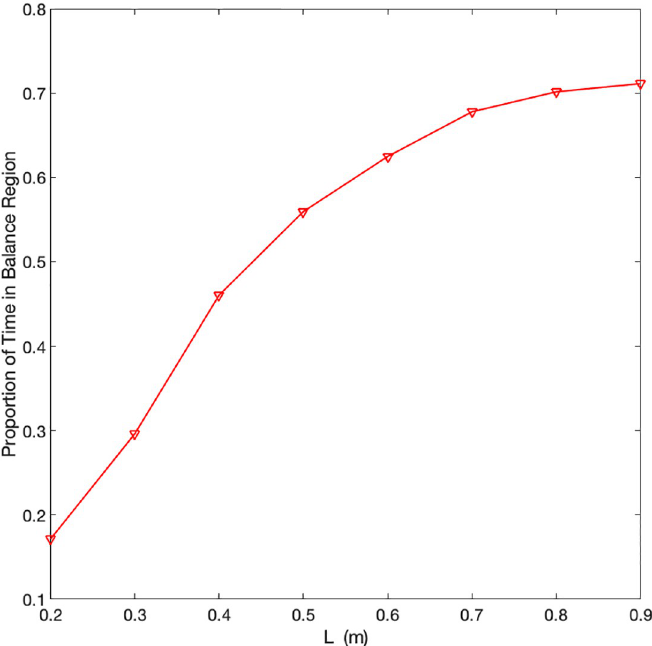
Fig 8. Proportion of the time spent by participants in the balancing region ( ± 0.27 rad from the vertical axis) for each pendulum length L .